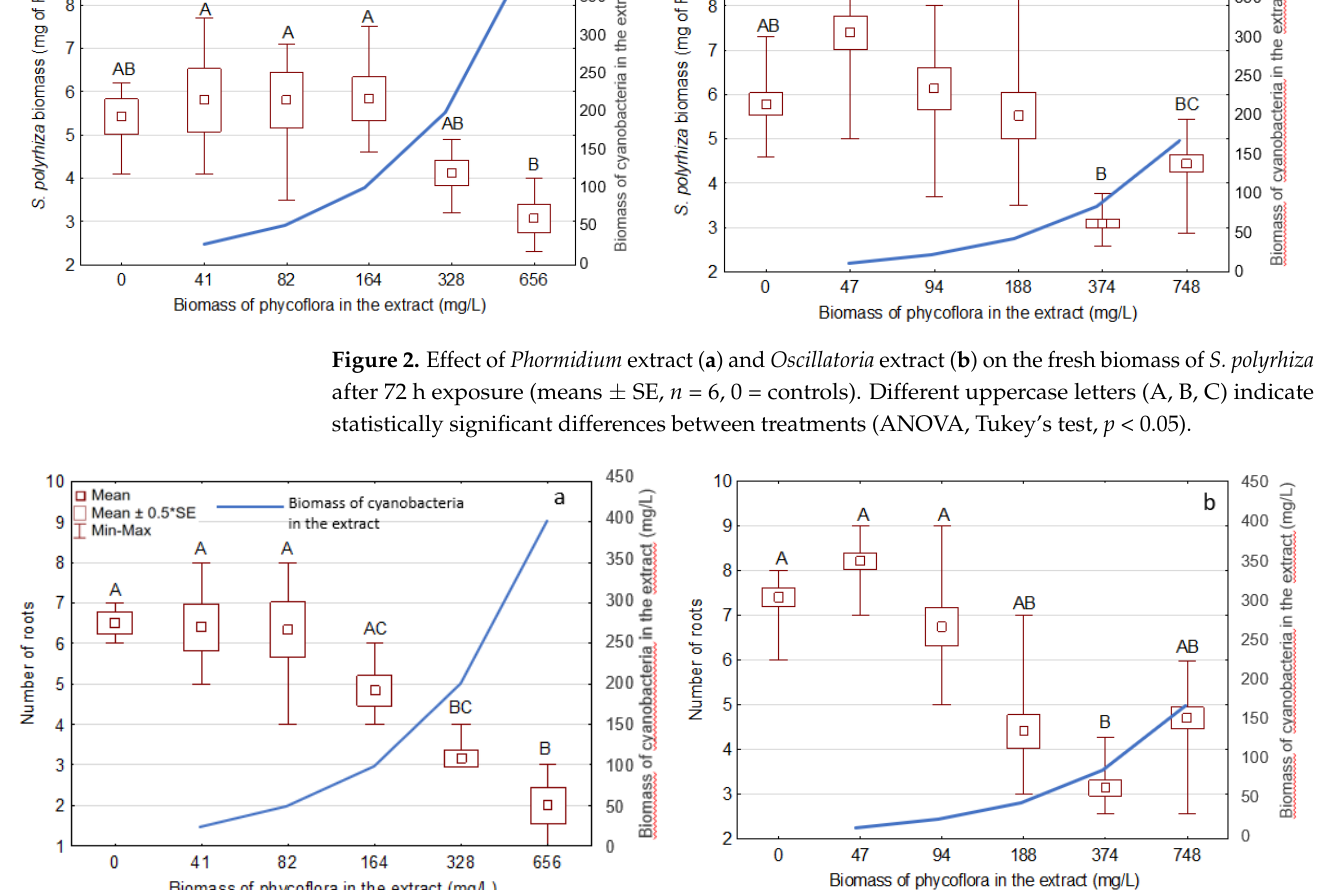
Table 2. Comparison of toxic effects of two the highest concentrations of the extracts obtained from similar phycoflora biomass and different cyanobacterial biomasses on S. polyrhiza, showing the im- portance and dependence of the effects observed on the concentration of cyanobacterial biomass.